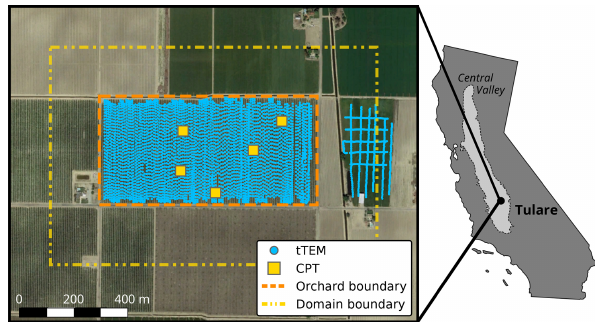
Figure 2. An aerial image of the study site and a map of California showing the location of the site within the Central Valley (light gray area). Individual tTEM soundings are shown as blue circles, while the location of each cone penetration test (CPT) is represented as a yellow square. The extent of the hydrologic model domain (dashed yellow line) is 200m larger in every direction than the extent of the almond orchard (dashed orange line). Satellite imagery © Google Earth